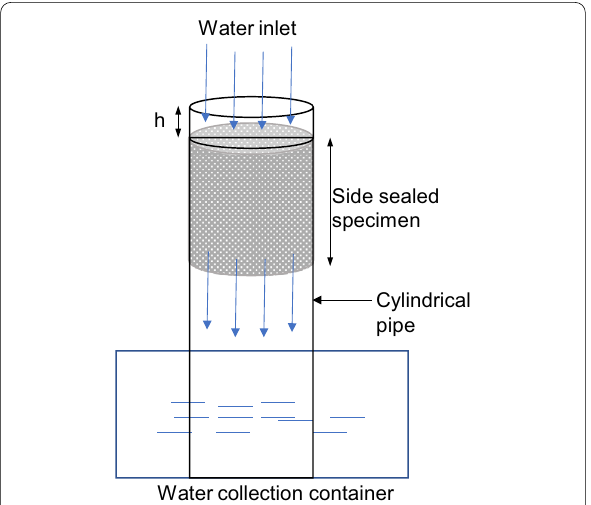
Fig. 5 Schematic of the constant head test method (ASTM C1701).